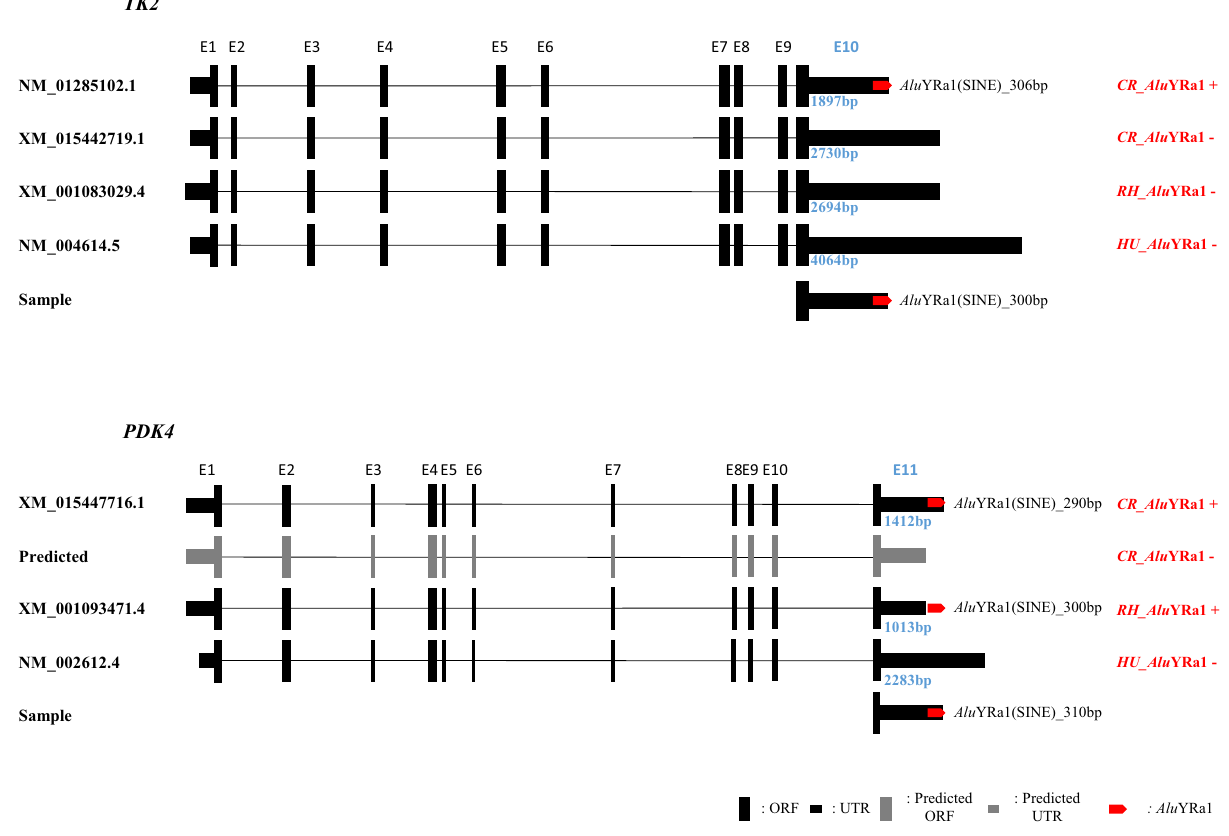
Figure 2. Structural analysis of TK2 and PDK4 of cynomolgus macaque, rhesus macaque, and humans. The sense-oriented Alu YRa1s are located at the terminal region of the transcripts of the cynomolgus macaque. Vertically longer boxes and shorter boxes represent ORF and UTR, respectively, and the red arrow box represents Alu YRa1. Gray boxes represent a predicted transcript because they are not yet registered in the database. This figure is a structural illustration and is not drawn to scale. ORF open reading frame, UTR untranslated region, CR crab-eating monkey, RH rhesus monkey, HU